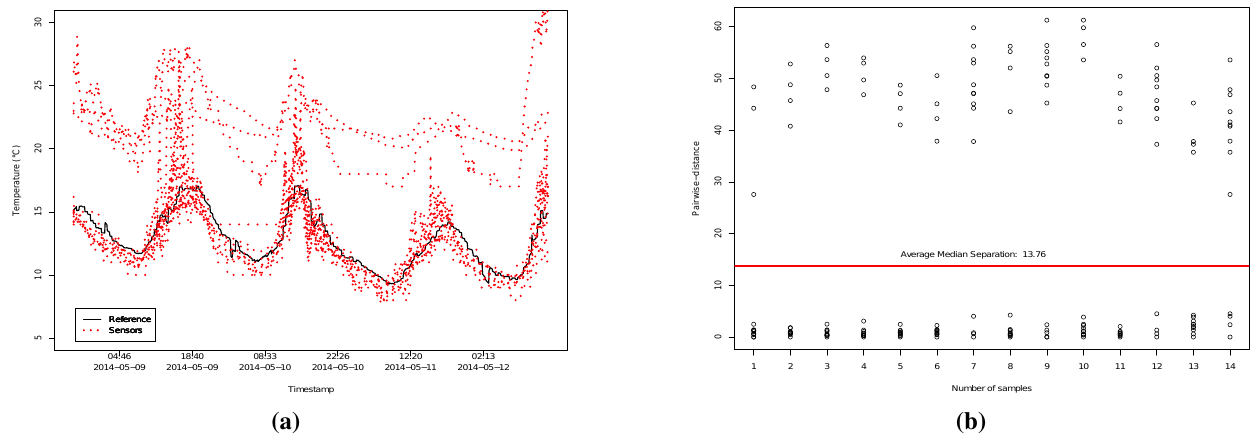
Figure 8. Analysis of the time-series and pairwise-distances between 14 reliable sensors with r ≥ 0 . 8 to the reference temperature data (Dataset 1). ( a ) Time-series analysis of those 14 reliable sensors; ( b ) Pairwise-distance between the time series of the reliable